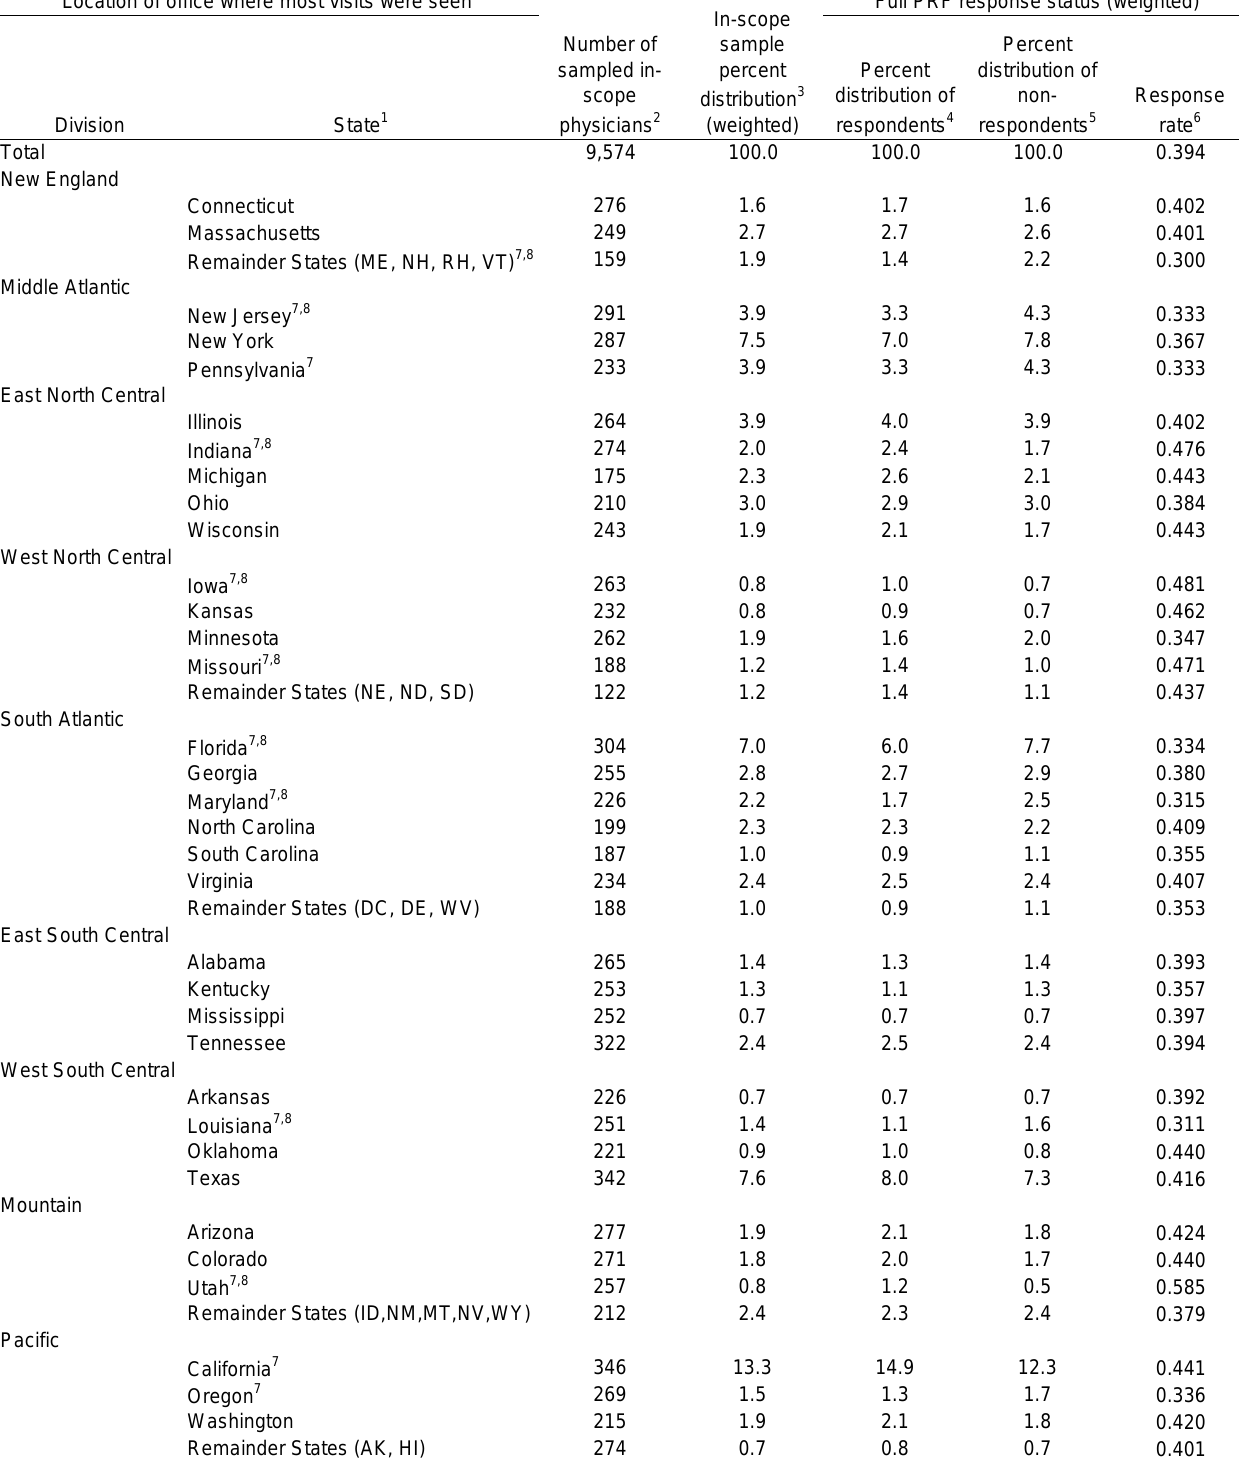
Table 32. In-scope sample physicians, their weighted percent distributions by Patient Record Form (PRF) response status, and PRF response rate, by state location of physician office: National Ambulatory Medical Care Survey, 2012 (Weighted by calibrated sampling